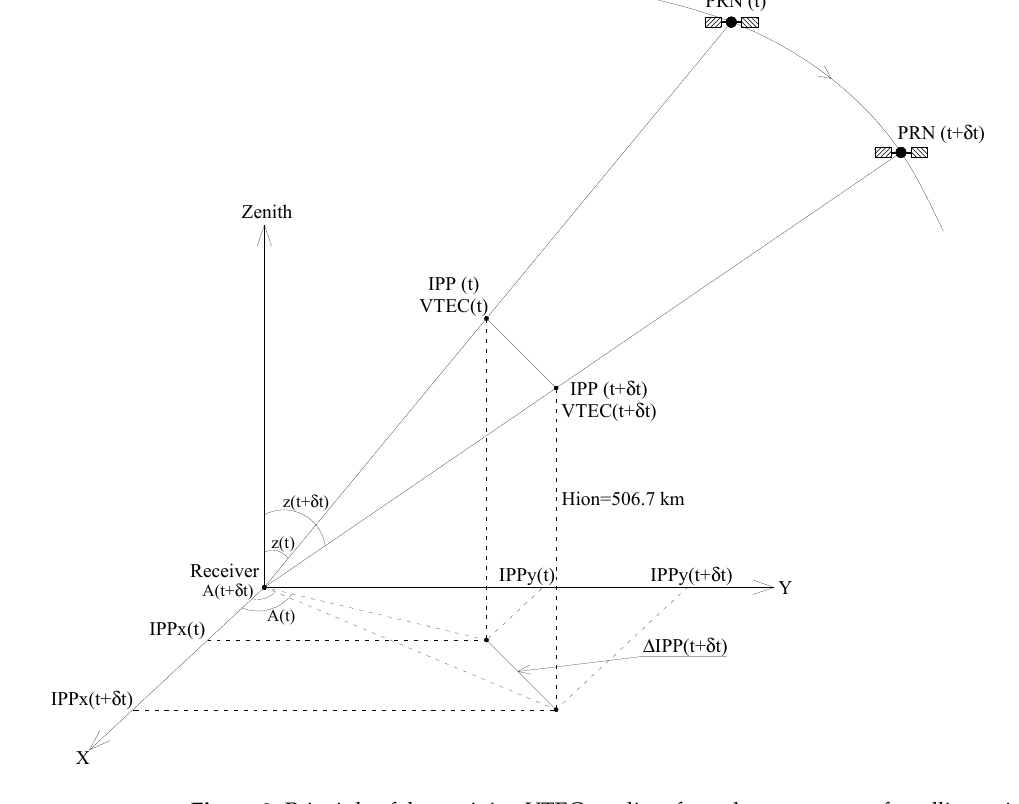
Figure 2. Principle of determining VTEC gradient from the movement of satellites using the projection of IPP on horizontal plane. This is calculated from the displacement of the satellites after each epoch, meaning it describes both temporal and spatial gradients of VTEC.